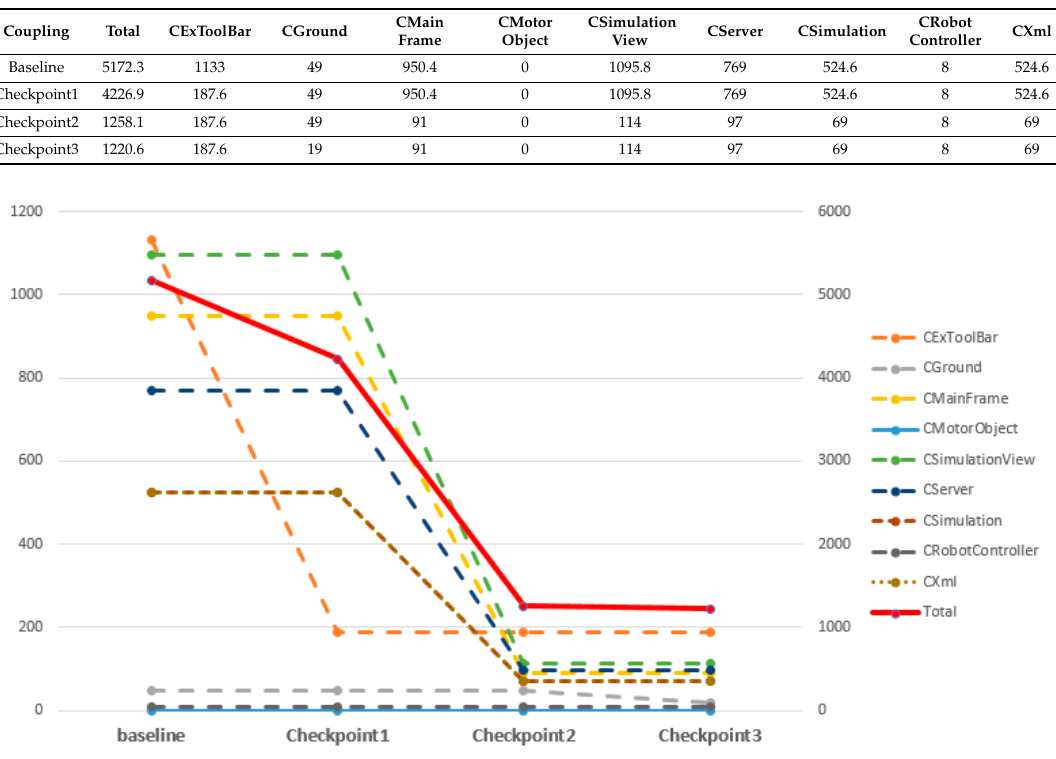
Table 3. Refactoring results.